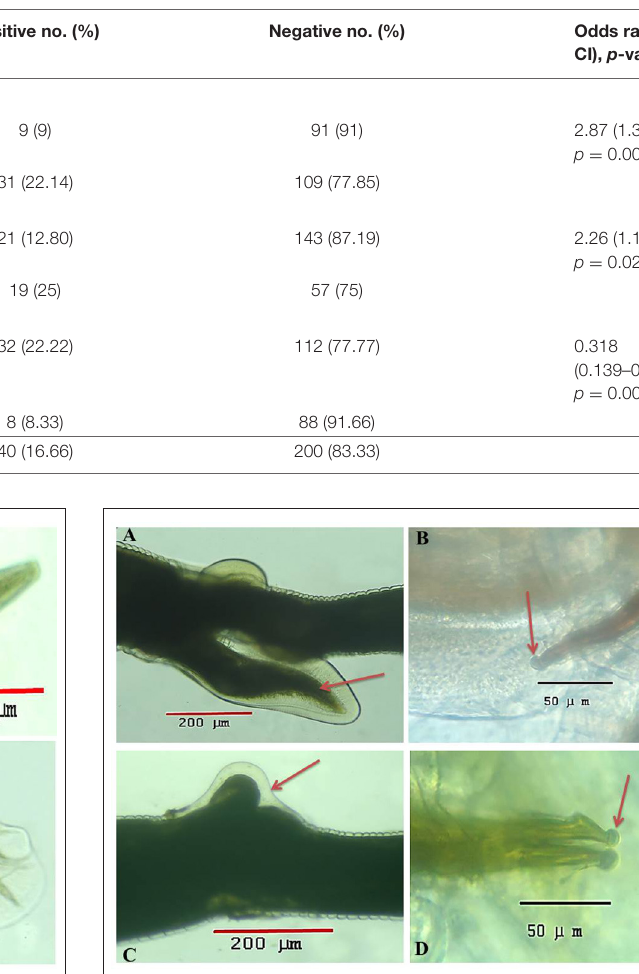
FIGURE 3 | Morphological and microscopic appearance of Haemonchus spp. in goats. (A) The anterior end of Haemonchus spp. showing the buccal capsule containing a lancet (arrow). (B) The anterior end of Haemonchus spp. showing a cervical papilla-like spine (arrow). (C) The tail region of female Haemonchus spp. showing an anal pore (arrow). (D) The posterior end of male Haemonchus spp. showing a copulatory bursa.